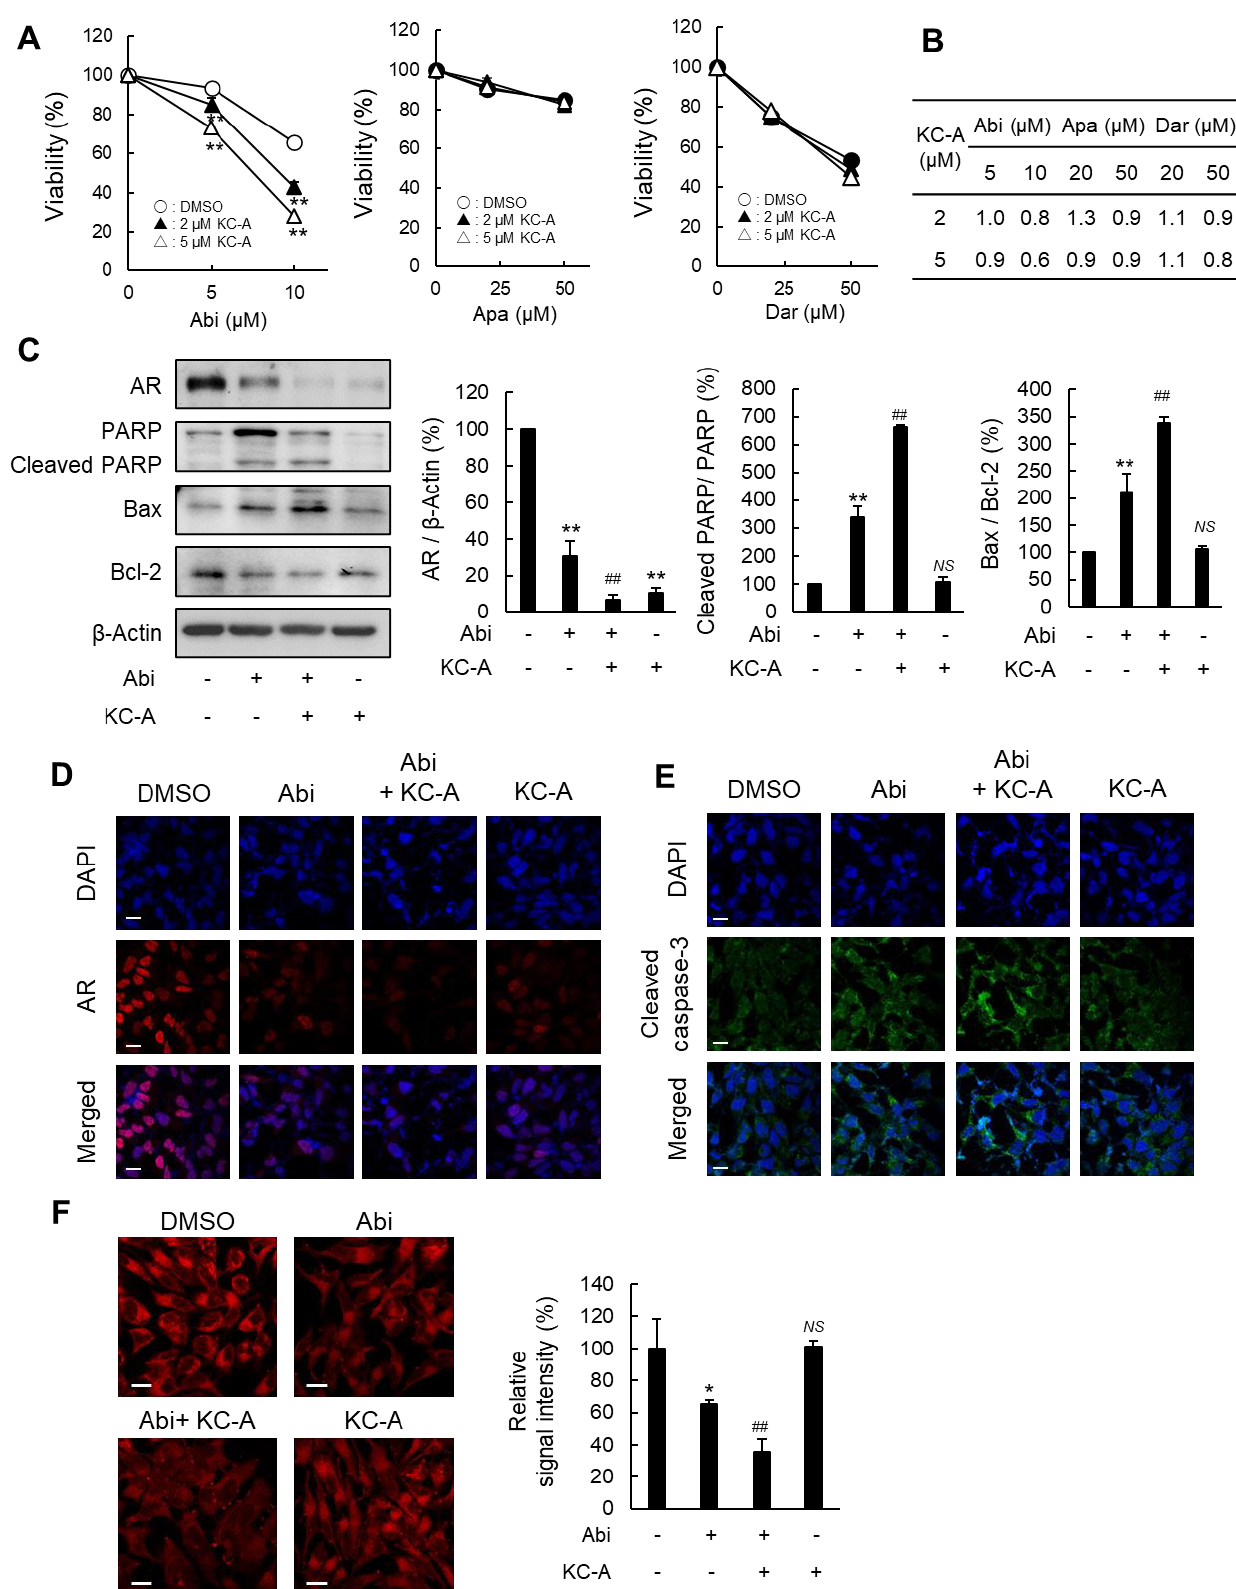
Figure 8. Effect of KC-A on Abi sensitivity in C4-2 cells. ( A ) Cell viability. The cells were treated with the indicated concentrations of CRPC drugs, Abi, apalutamide (Apa) or darolutamide (Dar) for 72 h in the absence or presence of indicated concentrations of KC-A and the cell viability was measured with an Alamar blue assay. ** p < 0.01 denotes significantly different from the cells treated with Abi alone. ( B ) Combined effects. Combination index (CI) values of the combination treatment were calculated by the CompuSyn software. CI < 1, CI = 1, and CI > 1 denotes synergism, additivity and antagonism effects, respectively. ( C – F ) The cells were treated without or with 10 μM Abi for 24 h in the absence or presence of 5 μM KC -A. ( C ) Protein expression of AR and apoptosis-associated proteins. The expression of AR, total and cleaved PARP, Bax, Bcl- 2 and β -actin in the cell extracts were analyzed by immunoblotting. The ratio of AR/β -actin, PARP/cleaved PARP or Bax/Bcl-2 is expressed as a percentage of that in the control cells treated with DMSO alone. ** p < 0.01, NS p > 0.05 compared with the control cells. ## p < 0.01 denotes significantly different from the cells treated with Abi alone. ( D , E ) Immunofluorescence staining. The cells were stained with DAPI (blue) and antibodies against AR (red, ( D )), cleaved caspase-3 antibody (green, ( E )). Merged images are also shown. Scale bar represents 20 μm. ( F ) MT-1 staining. Mitochondrial membrane potential of the cells was determined with a fluorescence probe MT-1. The fluorescence intensity was quantified using ImageJ, and the signal intensity in the treated cells is expressed as the percentage of that in the control cells treated with vehicle DMSO alone * p < 0.05, NS p > 0.05 compared with the control cells. ## p < 0.01 denotes significantly different from the cells treated with Abi alone. Scale bar repre- sents 20 μm. 3. Materials and Methods 3.1. Chemicals and Reagents ( E )-4-Methoxycinnamaldehyde (CAS RN: 24680-50-0), iodine (CAS RN: 7553-56-2) and boron tribromide (CAS RN: 10294-33-4) were purchased from TCI (Tokyo, Japan). 4′ , 6′ -Dimethoxy- 2′ -hydroxy-3-methyl acetophenone (CAS RN: 23121-32-6) was obtained from Carbosynth (Berkshire, UK). EtOH, DCM, DMSO, EtOAc and CHCl 3 were pur- chased from KANTO KAGAKU (Tokyo, Japan). DHT was purchased from TCI, and Adi- one, 11KDHT and 11KAdione were from Steraloids (Newport, RI, USA). Abi and carbe- noxolone were obtained from ChemScene (Monmouth Junction, NJ, USA) and Sigma-Al- drich (Saint Louis, MO, USA), respectively. All other chemicals were of the highest grade that could be obtained commercially.